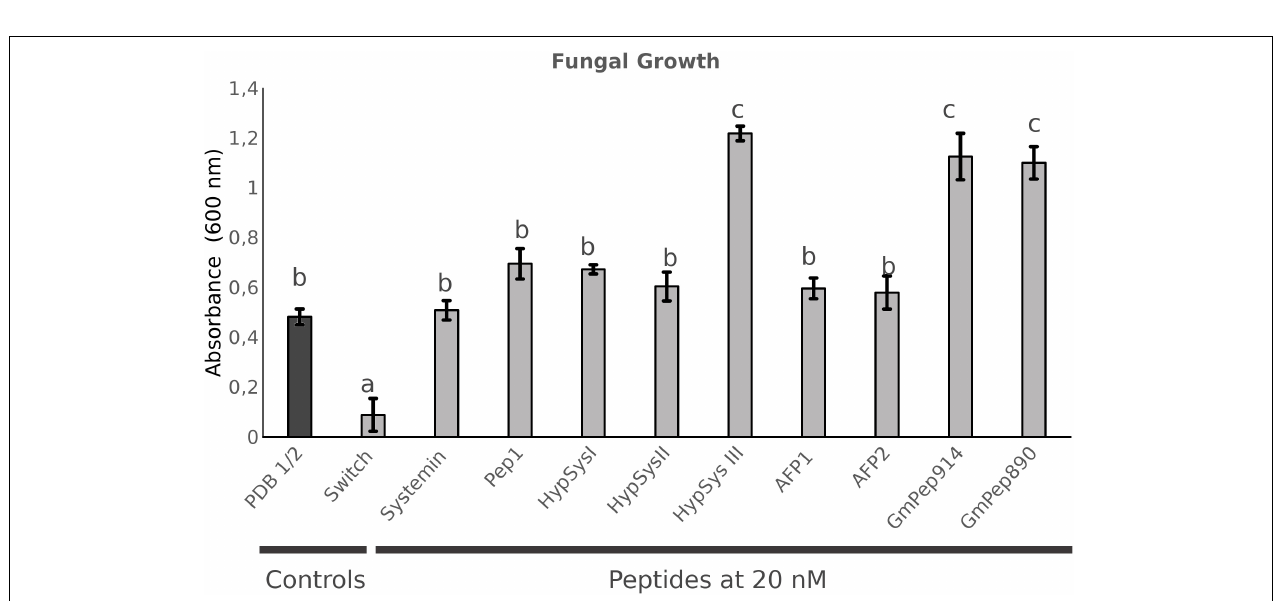
FIGURE 3 | In vitro antifungal assays. Plectosphaerella cucumerina growth measured after 24 h growing in liquid medium containing each peptide at a concentration of 20 nM. Fungal growth was measured as the level of turbidity (absorbance 600 nM). A commercial fungicidal (Switch) was used as a positive control. Bars represent mean ± standard error (SD), n = 3. Different letters indicate statistically significant differences (ANOVA, Fisher’s Least Significant Difference (LSD) test; P < 0.05, n = 3).